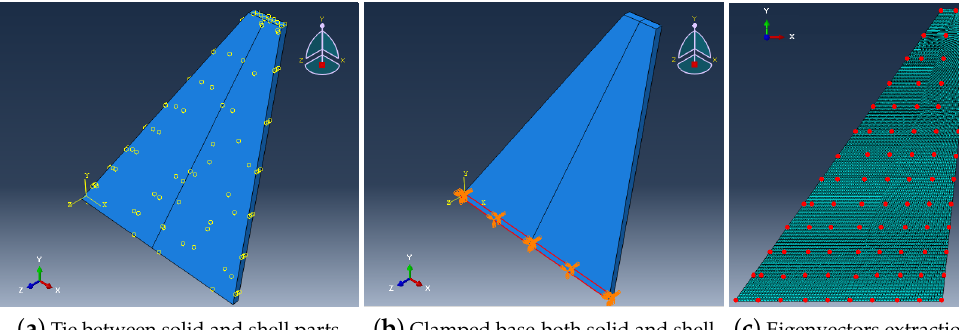
Figure 3. Full scale model—boundary